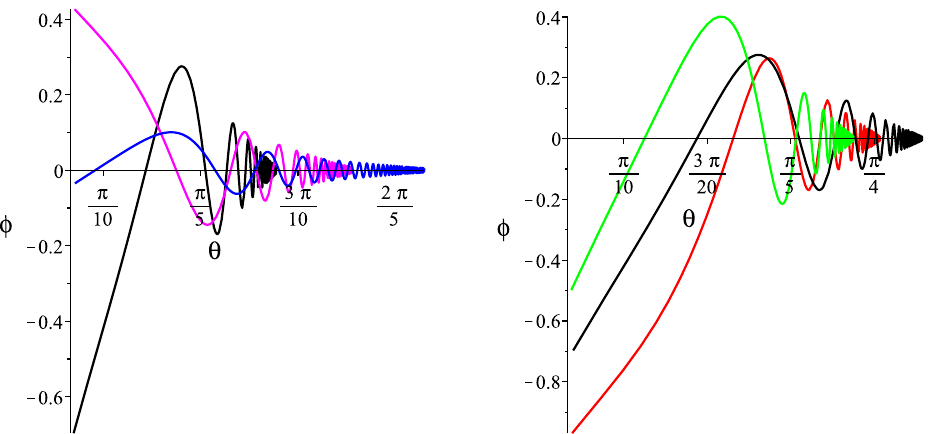
Figure 10 . Plots of ’ ( t ) for several values of C u C u = (cid:0) 4 (black line), C u 2 and C u takes the values: C u 1 that the black lines on the left and right sides are the same curve.